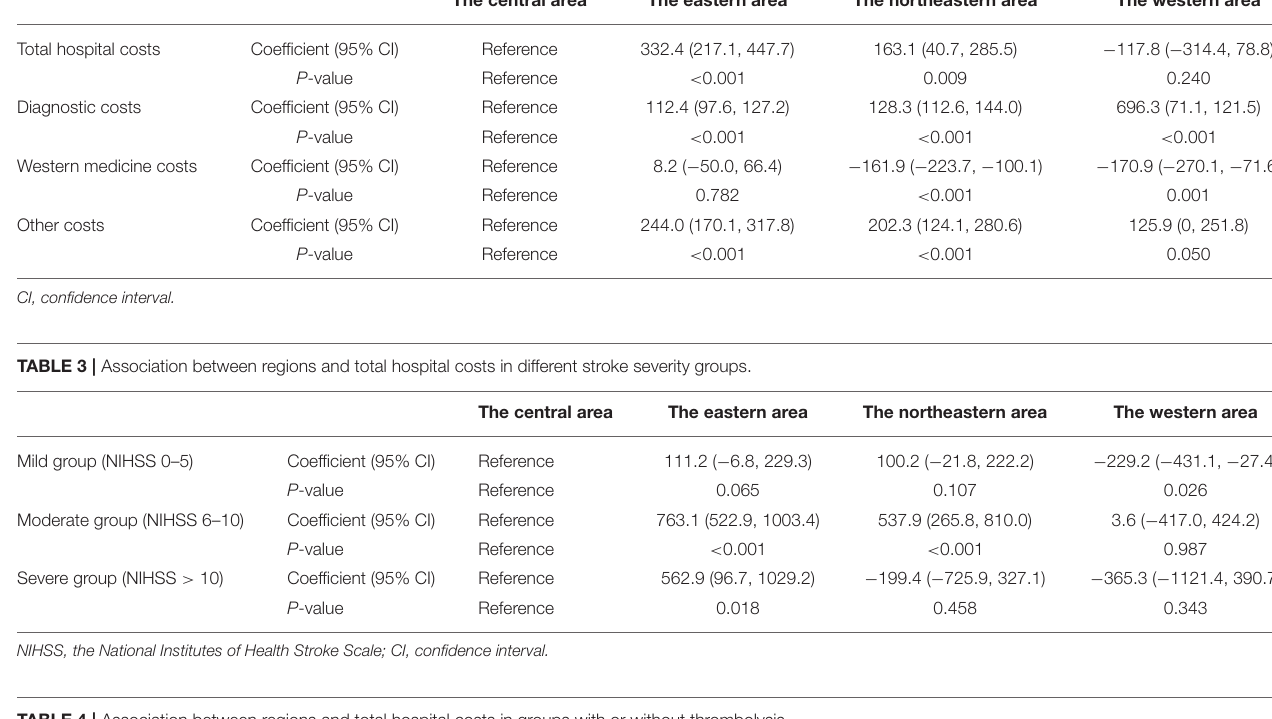
TABLE 4 | Association between regions and total hospital costs in groups with or without